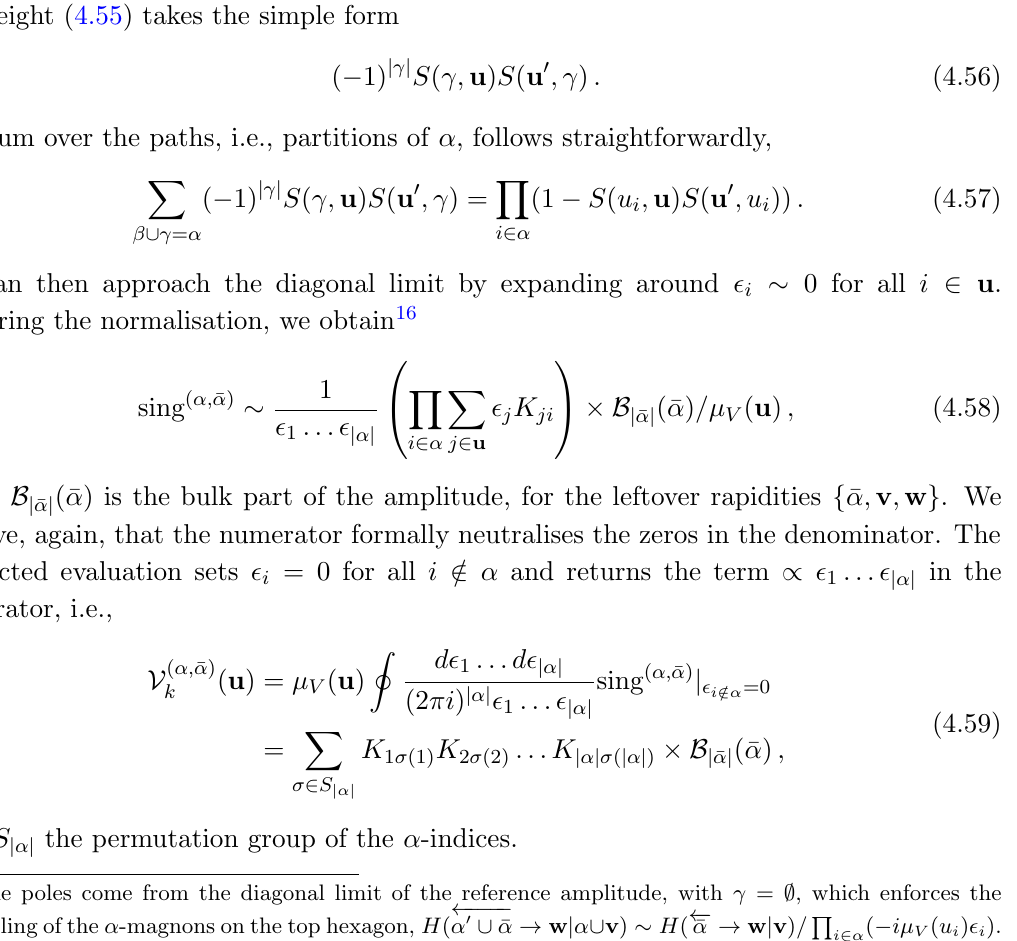
Figure 19 . Process contributing to the singular part of the form factor. A subset (cid:11) = (cid:12) incoming magnons u = (cid:11) (cid:22) (cid:11) moves straight to the next hexagon with a fraction (cid:12) of it landing [ on the far left of the operator and its complement (cid:13) on the far right. The remaining magnons (cid:22) (cid:11) in the incoming state are absorbed by the operator or smoothly di(cid:11)used into the adjacents magnons v w in its surroundings. For the top process, we turn the picture around. Paying attention [ to our convention for ordering the magnons around the hexagon, we read out the form